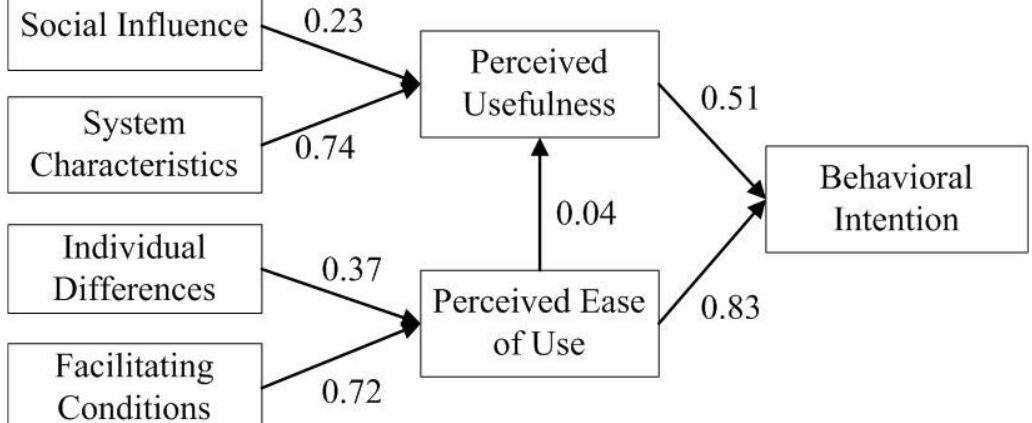
Figure 3. The path coefficient graph of the structural equation